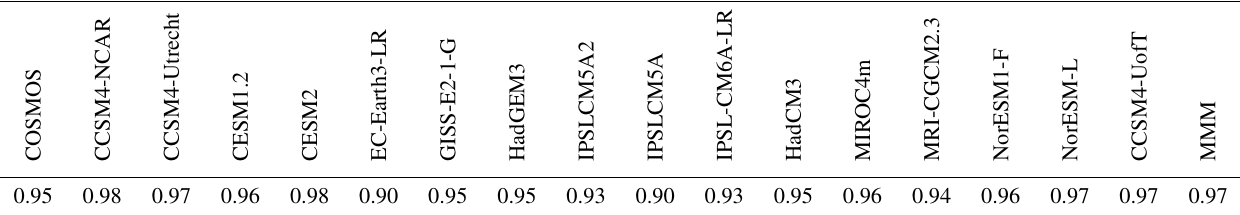
Table 2. Pattern correlation of July–September mean rainfall over West Africa (0–25 ◦ N, 30 ◦ W–30 ◦ E) between PlioMIP2 PI simulations, including the MMM and observational data (CRU TS v4.: 1901–1930